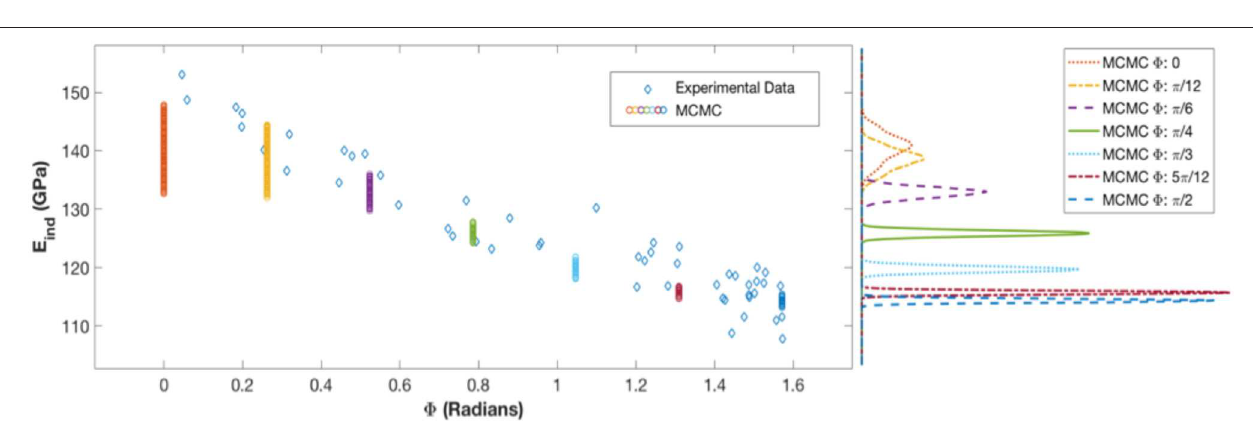
FIGURE 10 | ( Left ) Reduced-order model evaluations of the Markov Chain (MCMC) at selected points across the orientation space compared to available experimental data. ( Right ) The resulting distributions of the evaluations using the reduced order model.